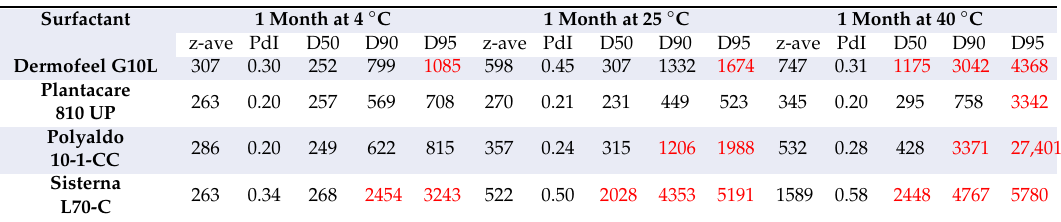
Table 2. Particle size (PCS z-ave, LD D50, D90 and D95 all in [nm]) and polydispersity index (PdI) of Symurban nanocrystals produced with 1.5% of the 4 best surfactants after 1 month storage at 4, 25, and 40 ◦ C, showing that Plantacare 810 UP provides the highest physical storage stability. Values exceeding the nm-range were written in